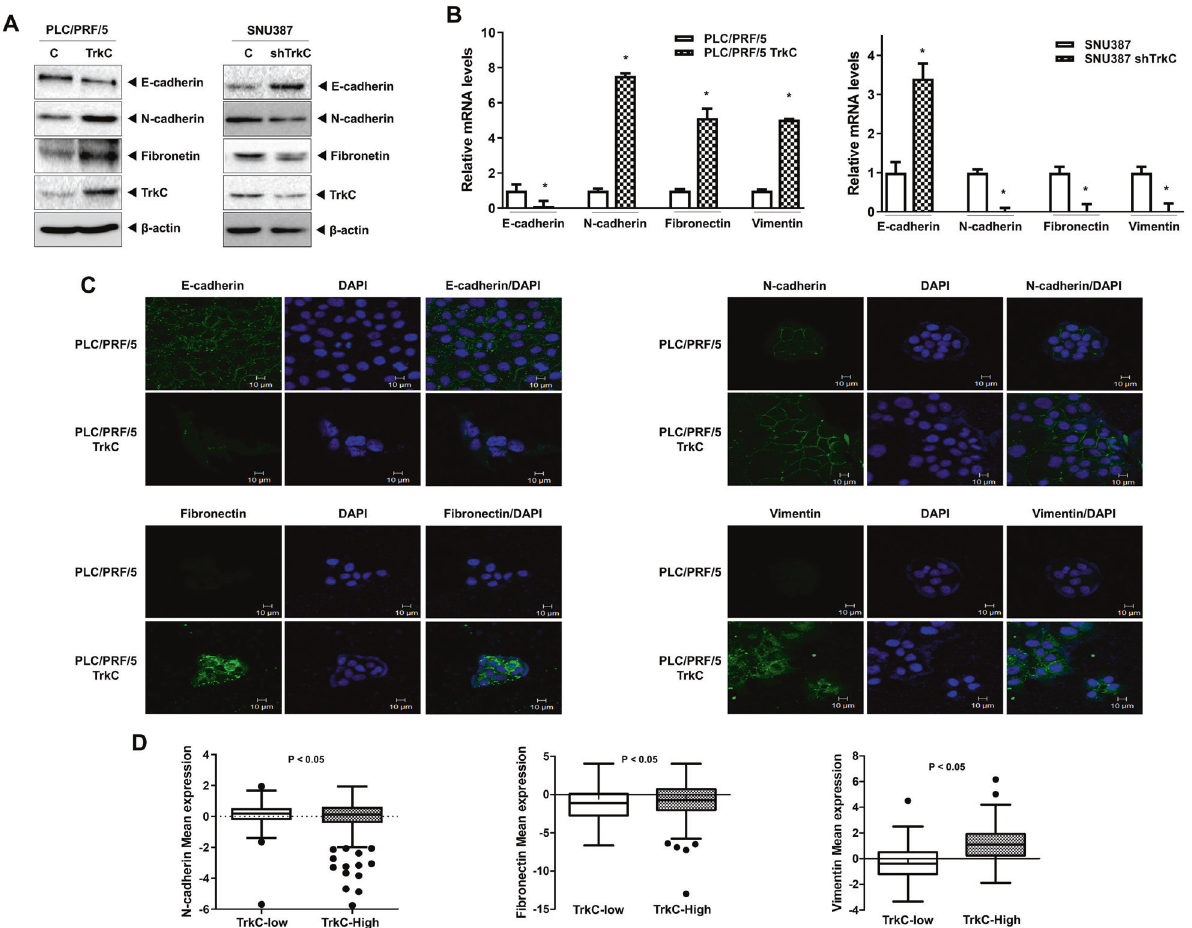
N-cadherin, fi bronectin, and vimentin in PLC/PRF/5, PLC/PRF/5 TrkC, SNU387 control-shRNA, and SNU387 TrkC-shRNA cells. n = 3. P < 0.05 (*) relative to SNU387; t -test. C Immuno fl uorescence analysis of indicated mesenchymal ( fi bronectin, vimentin, and N-cadherin) and epithelial (E- cadherin) markers in PLC/PRF/5 or TrkC overexpression cells. The nuclei of cells were stained with DAPI (blue). D The relative mRNA expression of indicated mesenchymal markers (N-cadherin, fi bronectin, and vimentin) in HCC patients between high or low TrkC expression. The